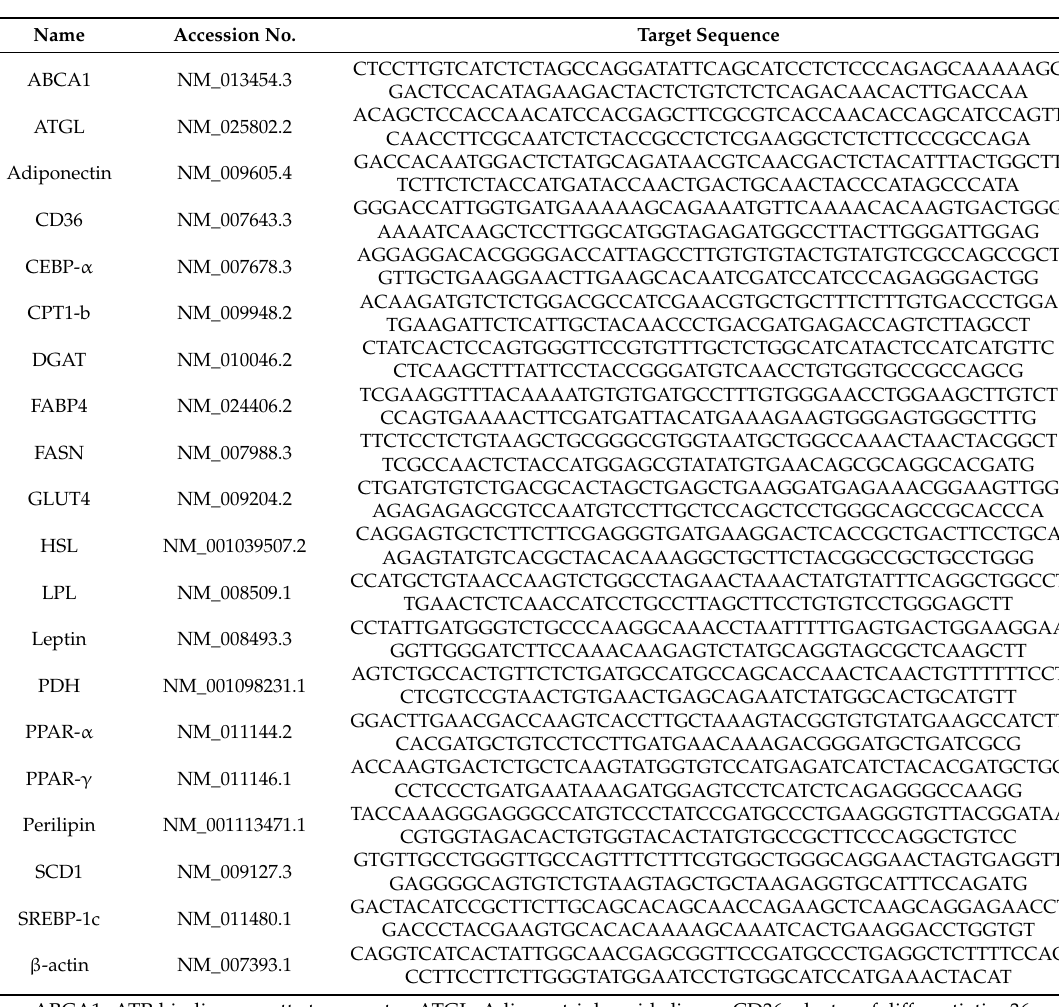
Table 3. NanoString Target Sequences in white adipose tissue